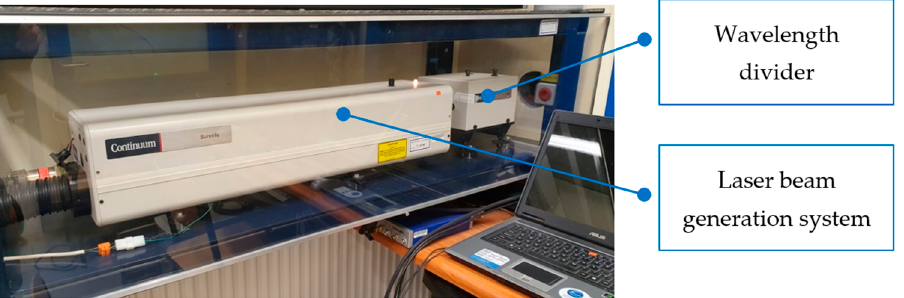
Figure 4. View of the laser beam generation system.